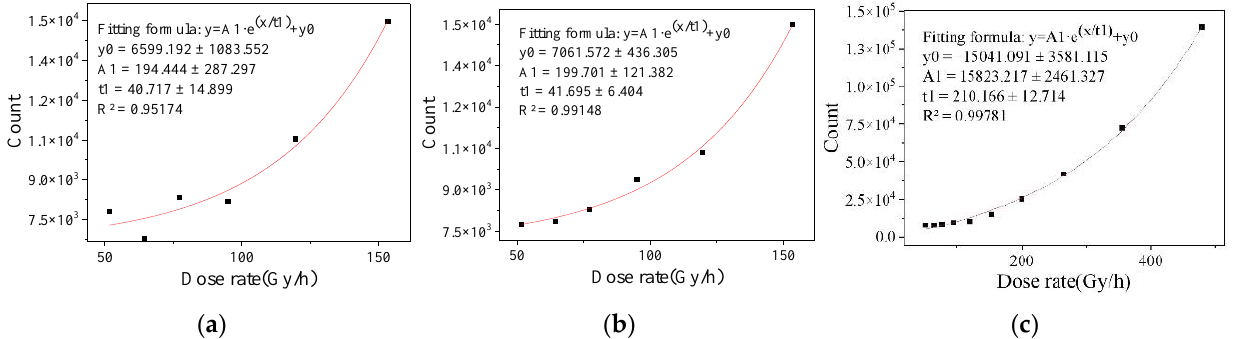
Figure 5. Convergence efficiency of binarized eigenvalue in bright image irradiation chamber. ( a ) 1 frame of image data, ( b ) 2 frames of image data and ( c ) 50 frames of image data.